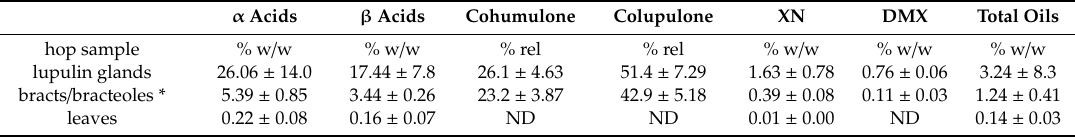
Table 3. Analysis of metabolome content in leaves, bracts and lupulin glands of hop. α Acids β Acids Cohumulone Colupulone XN DMX Total Oils hop sample % w / w % w / w % rel % rel % w /